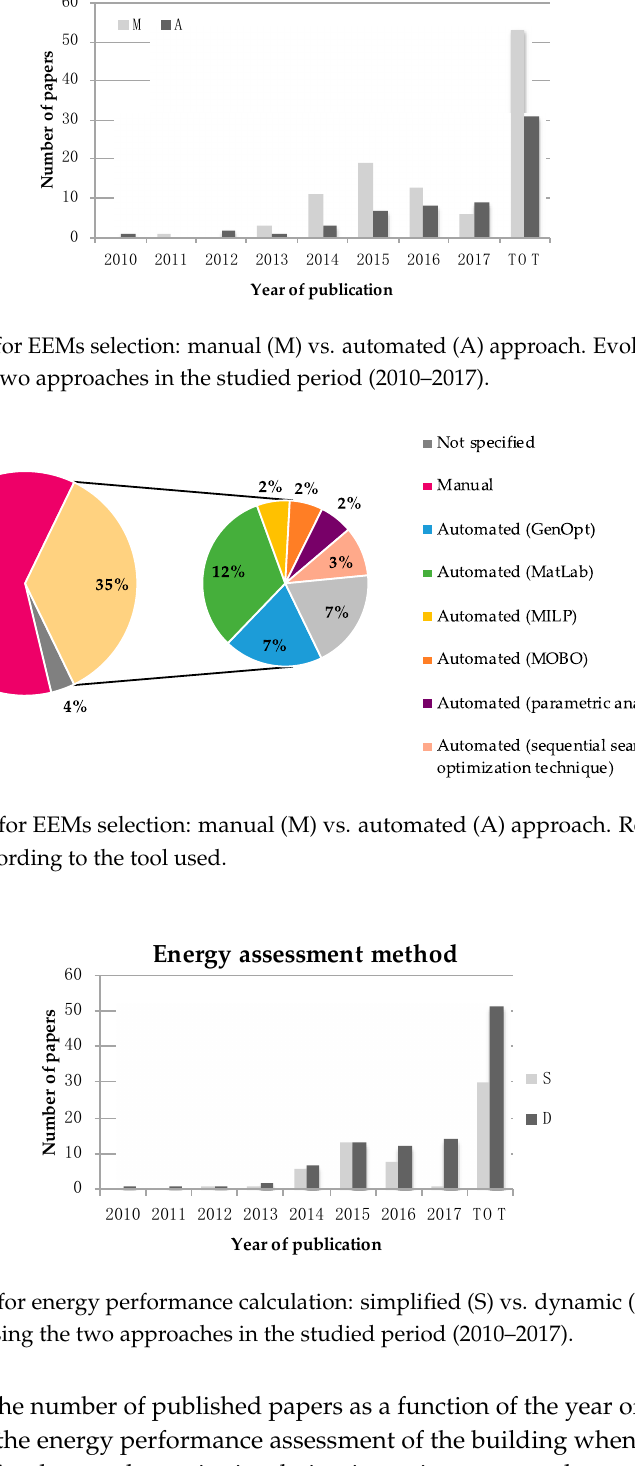
Figure 13. Methods for energy performance calculation: simplified (S) vs. dynamic (D). Repartition of the analyzed papers according to the tool used.